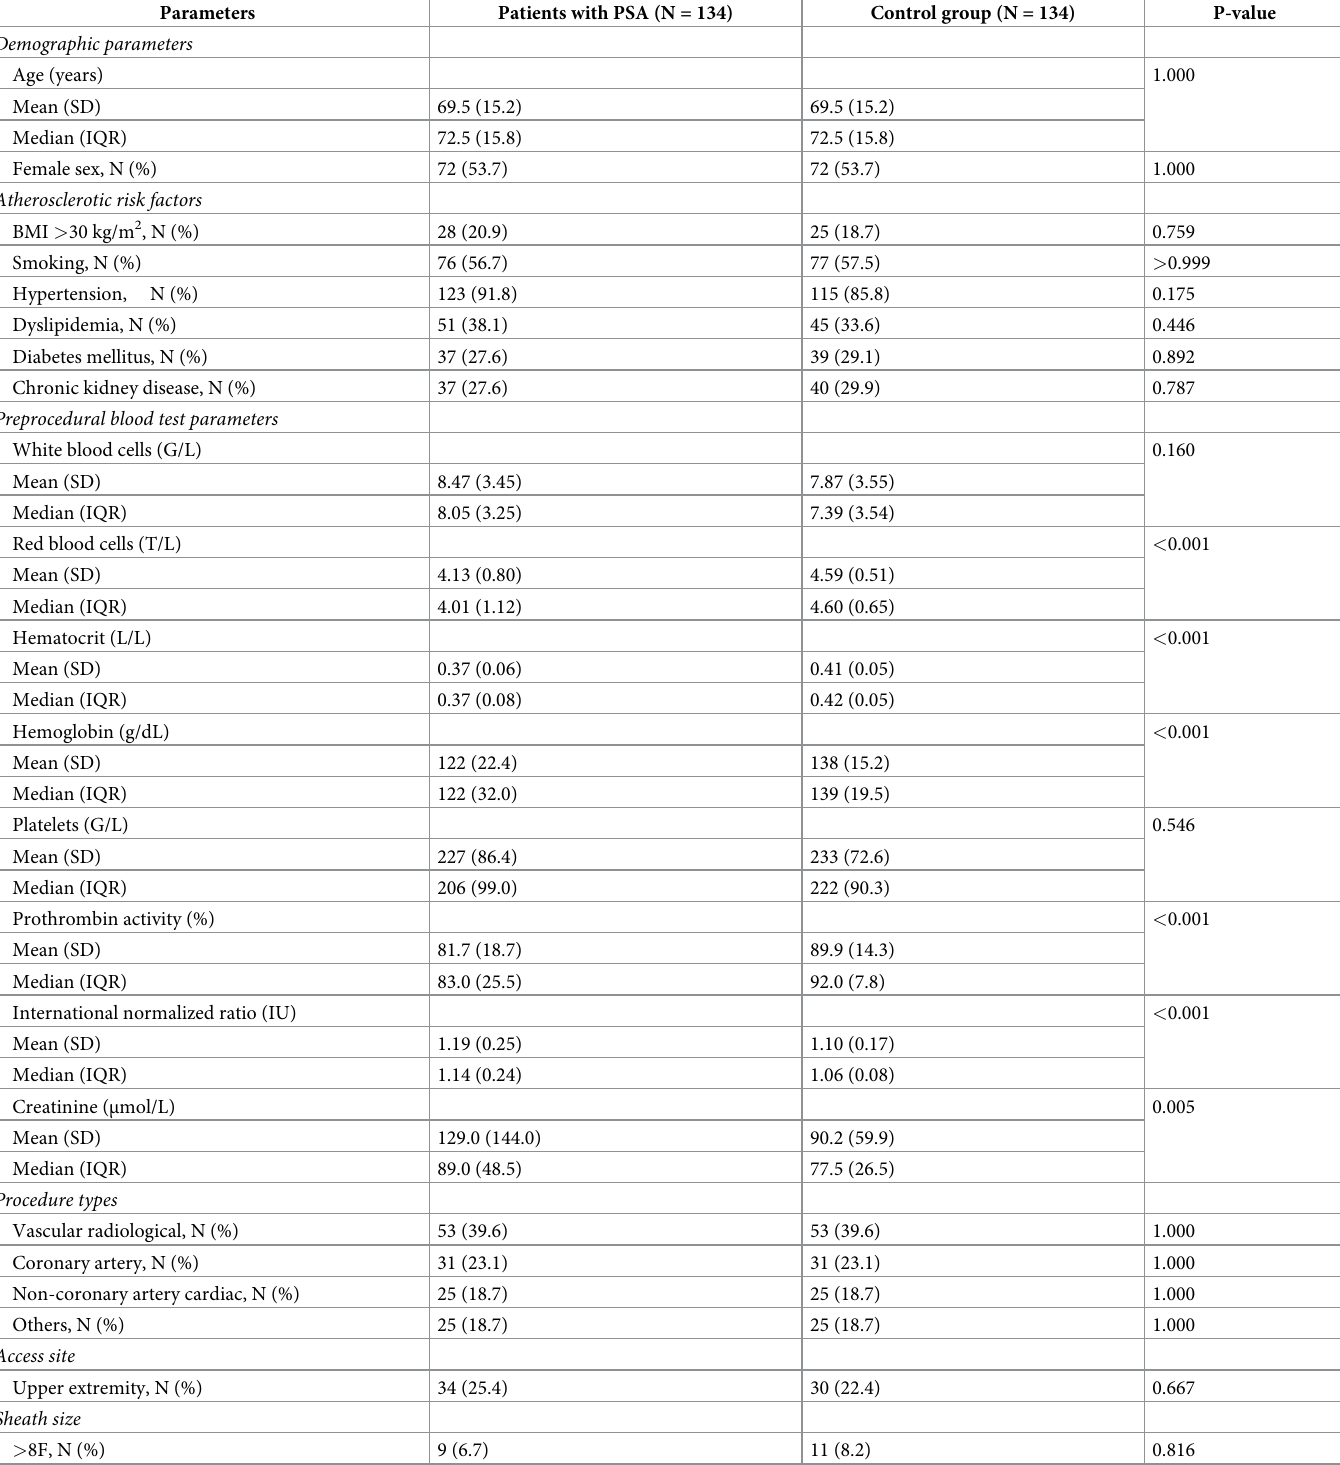
Table 1. Characteristics of the pseudoaneurysm and the control